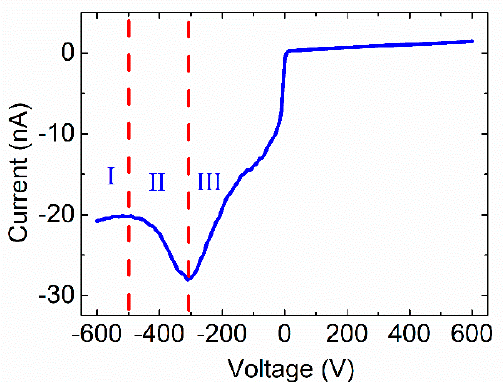
Figure 5. The typical X-ray photocurrent response of CdZnTe photon counting detectors. The tube current is 0.6 mA, the X-ray tube voltage was set to 80 kV.